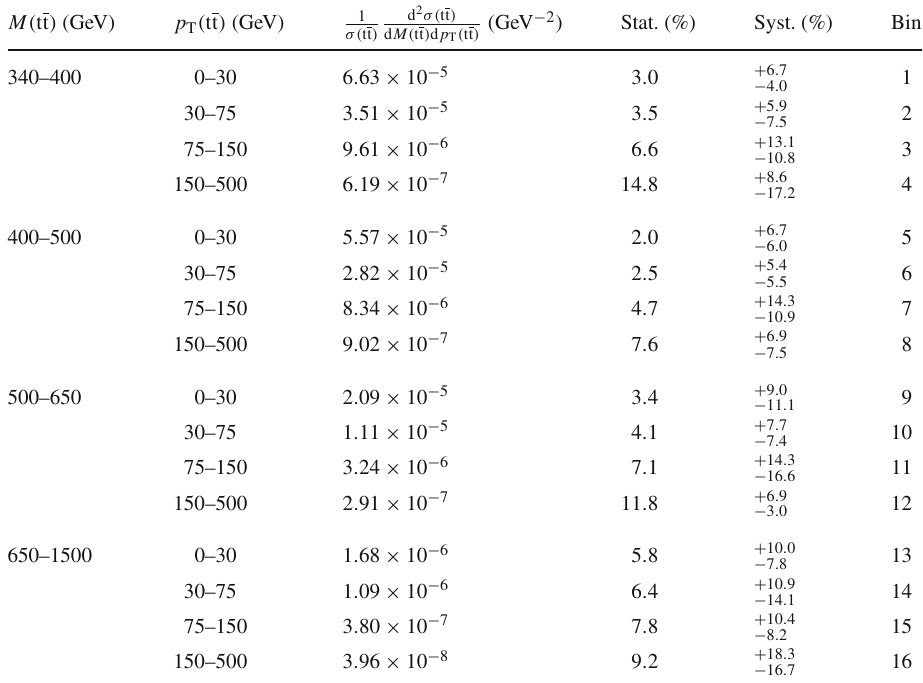
Table 17 The measured normalized tt double-differential cross sections in different bins of M ( tt ) and p T ( tt ) , along with their relative statistical and systematic uncertainties